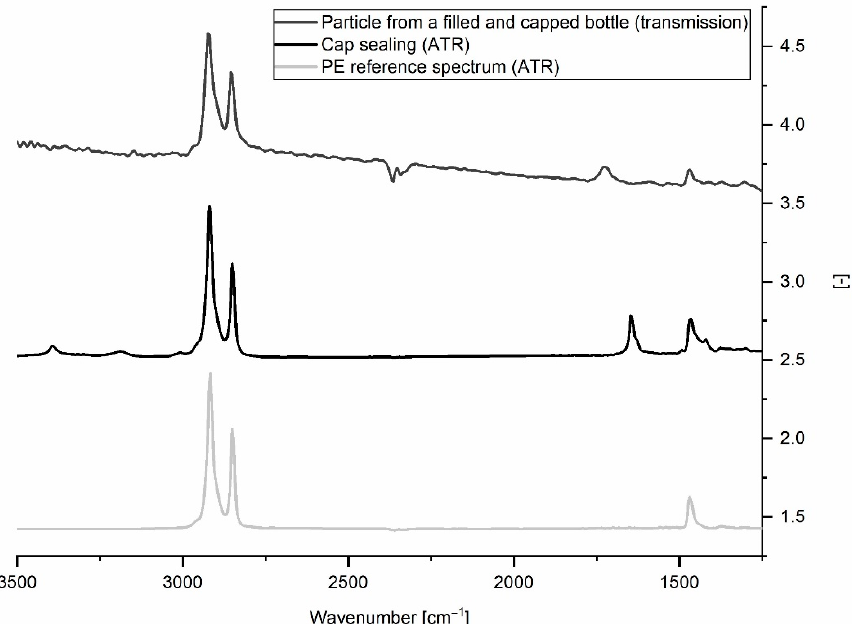
Figure 8. Example of transmission spectrum of a PE-like particle from a filled and capped water bottle compared to ATR spectra of cap sealing and PE reference material.